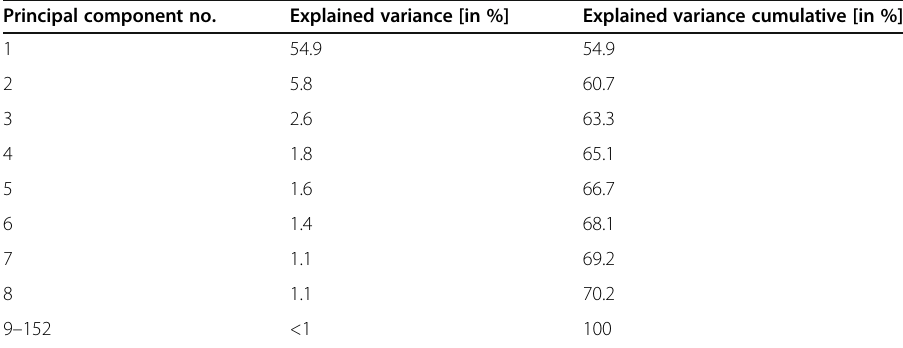
Table 4 Shares of variance explained by all logit-mortality rate time series Principal component